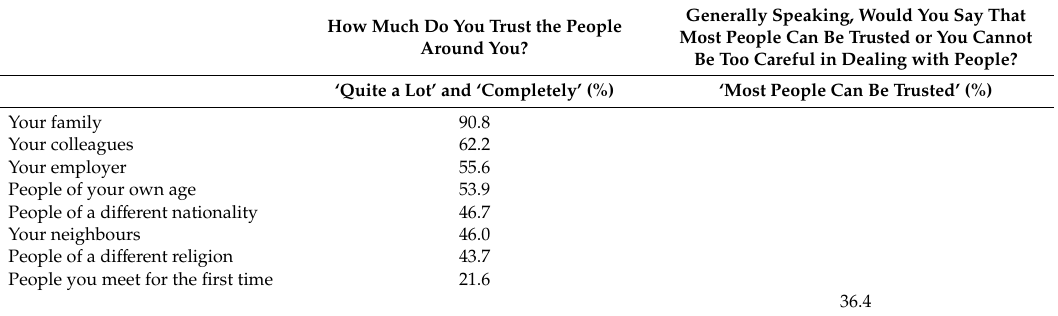
Table 2. Levels of trust in di ff erent groups of people.